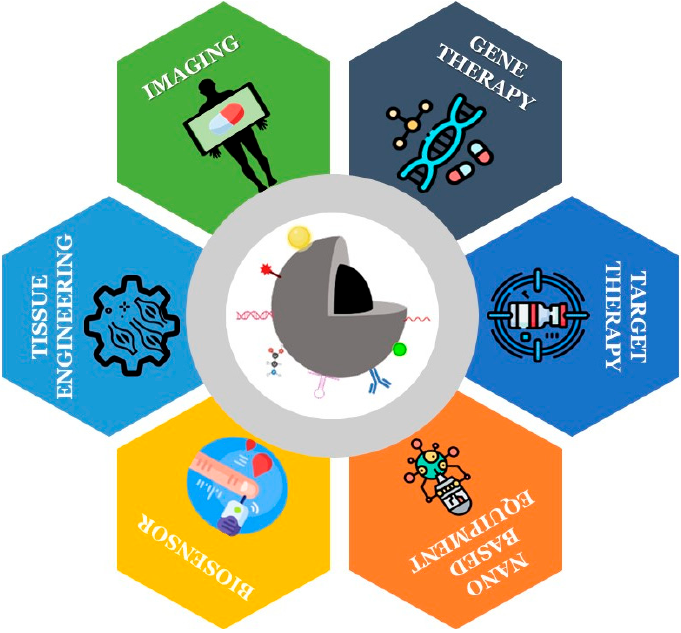
Figure 3. Application area for MNP.